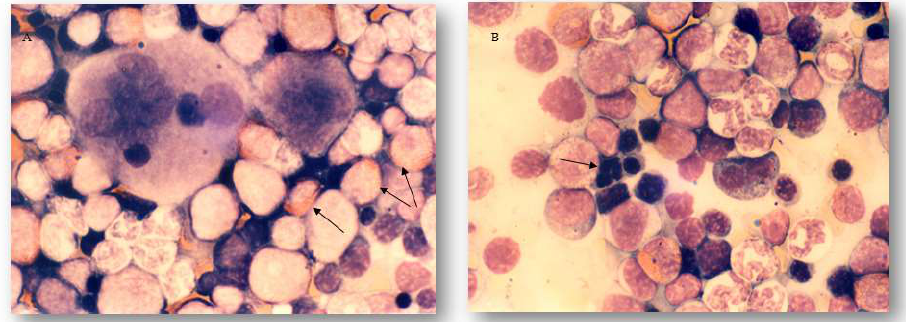
Figure 4. Light micrographs of the bone marrow of rats 28 days after receiving last treatment. May-Grünwald–Giemsa stain, magnification 1000×. ( A ) Eosinophilia in the bone marrow of the DOX-only treated rats 28 days after receiving last treatment marked with arrows. ( B ) Sign of dyserythropoiesis in the bone marrow of the DOX-only treated rats 28 days after receiving last treatment marked with arrow.